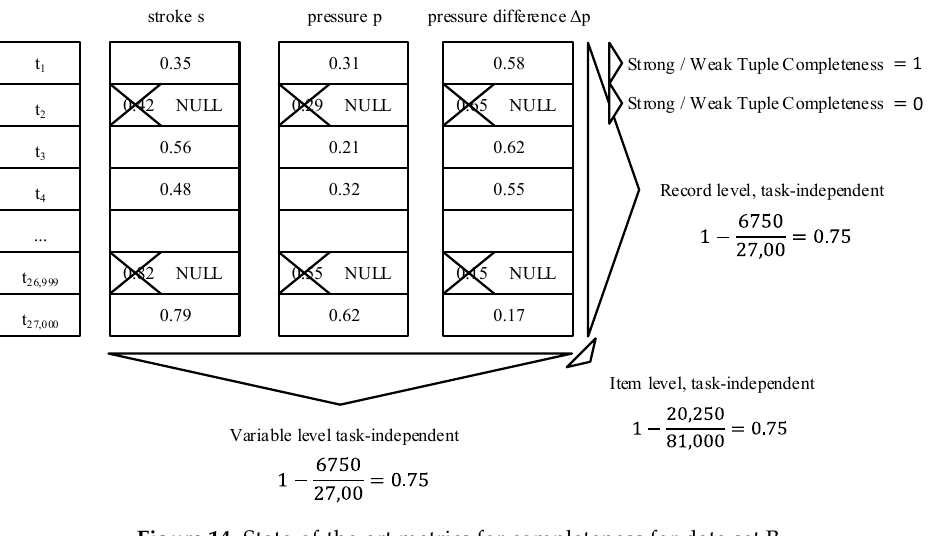
Figure 14. State ‐ of ‐ the ‐ art metrics for completeness for data set B. Figure 14. State-of-the-art metrics for completeness for data set